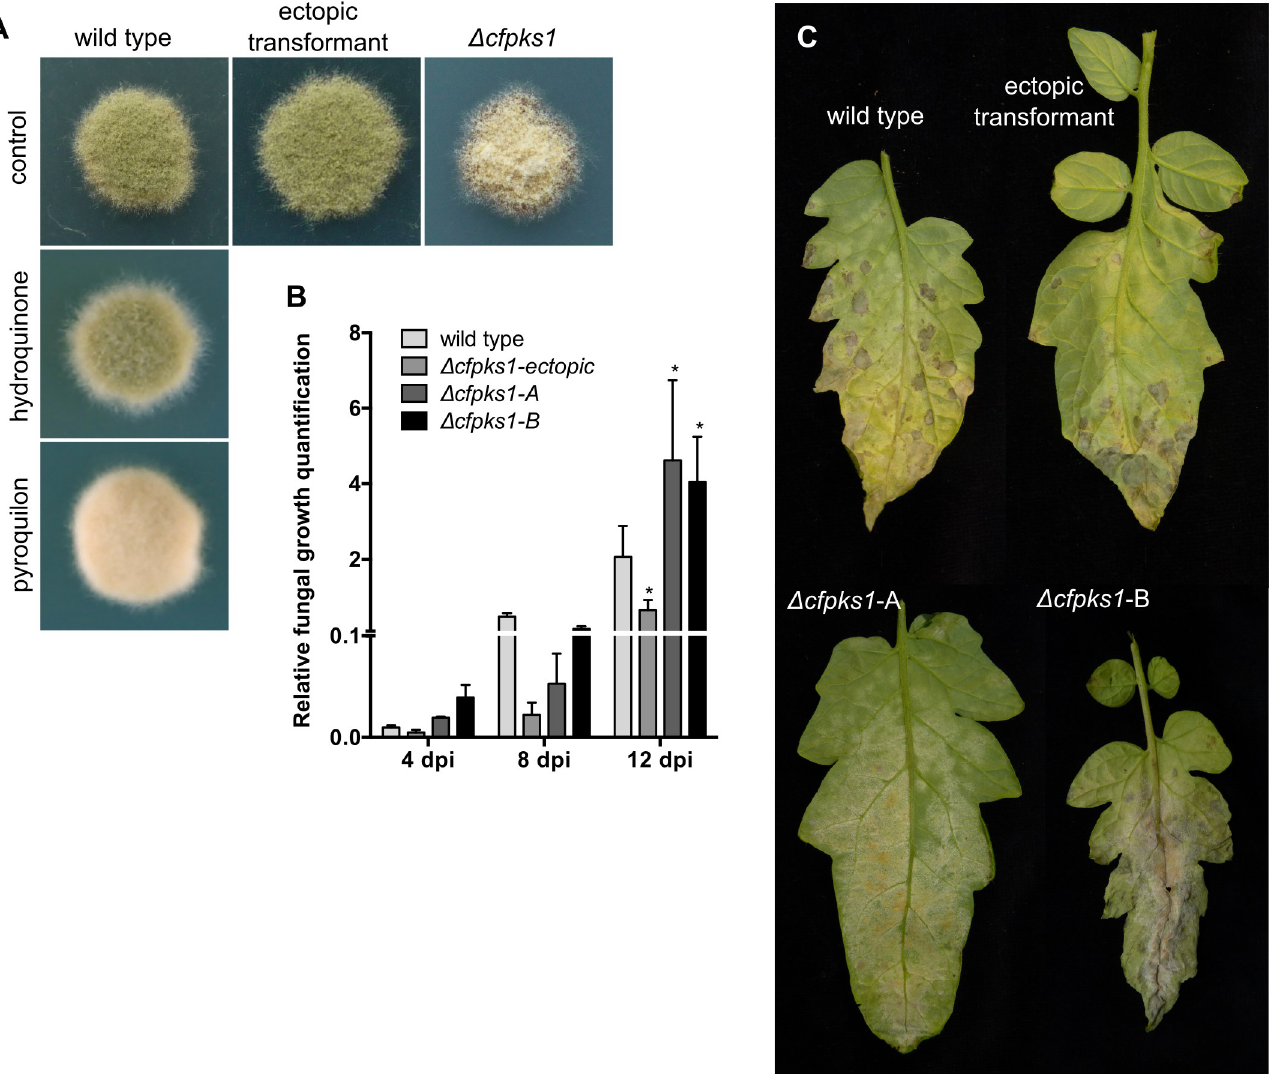
Fig 4. Characterization of Cladosporium fulvum Δ cfpks1 deletion mutants. (A) In vitro growth of wild-type C . fulvum , ectopic transformant and Δ cfpks1 deletion mutants on Potato Dextrose Agar (PDA) medium; and wild-type C . fulvum on PDA supplemented with 30 mg.L -1 DHN biosynthesis inhibitor (pyroquilon) or DOPA melanin biosynthesis inhibitor (hydroquinone) [7]. (B) Quantification of fungal growth during tomato infection by wild type, an ectopic transformant and Δ cfpks1 deletion mutants. (C) Tomato leaves infected by wild type, an ectopic transformant and Δ cfpks1 deletion mutants at 16 days post- inoculation